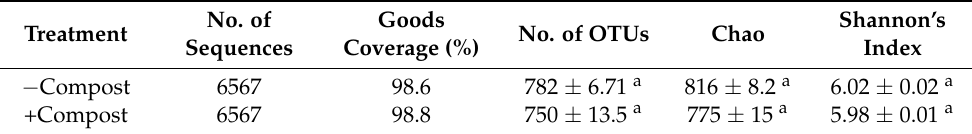
Figure 1. ( a ) The 16S rRNA copy numbers of soil bacterial communities estimated by qPCR. ( b ) The principal coordinate analysis (PCoA) showing the clustering of bacterial communities be- tween soil samples. Values for 16S rRNA data are plotted with mean; error bars indicate standard errors; different letters on plot mean significant difference ( p < 0.05) between treatments according to Tukey’s test. Table 1. Summary data for 16S rRNA sequencing results and α -diversity of the soil samples.